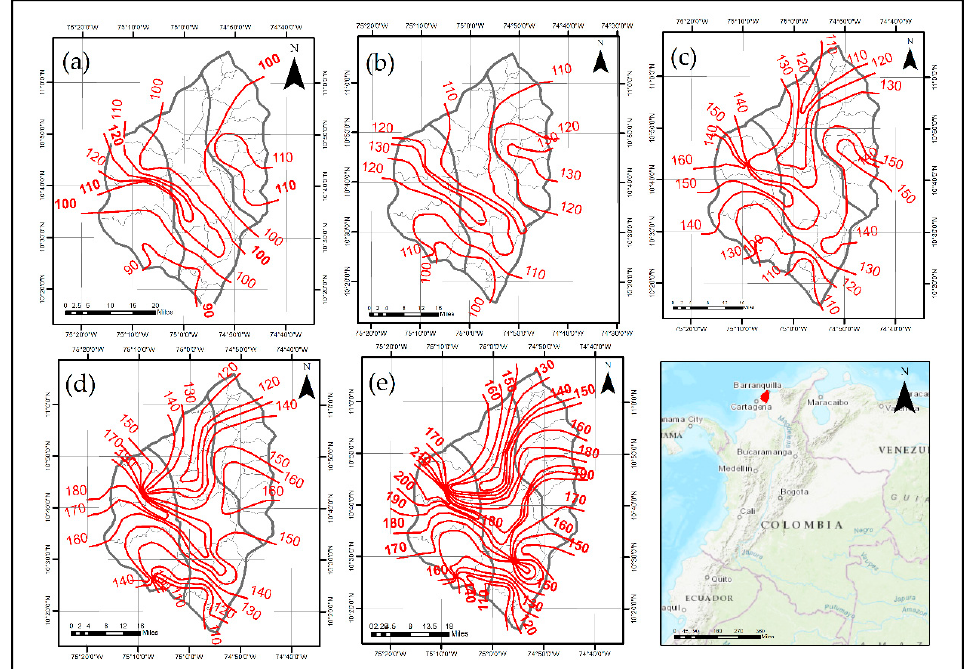
Figure 9. Non-stationary conditions (NSC) isohyetal maps: ( a ) five years, ( b ) 10 years, ( c ) 25 years, ( d ) 50 years, and ( e ) 100 years.